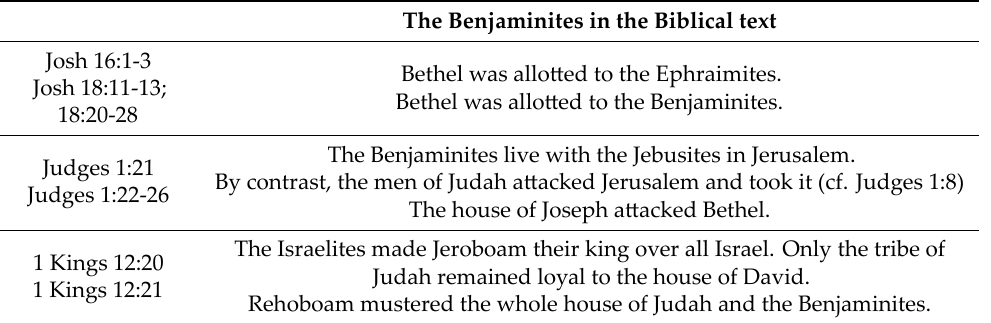
Table 1. The ambiguous position of the Benjaminites. The Benjaminites in the Biblical